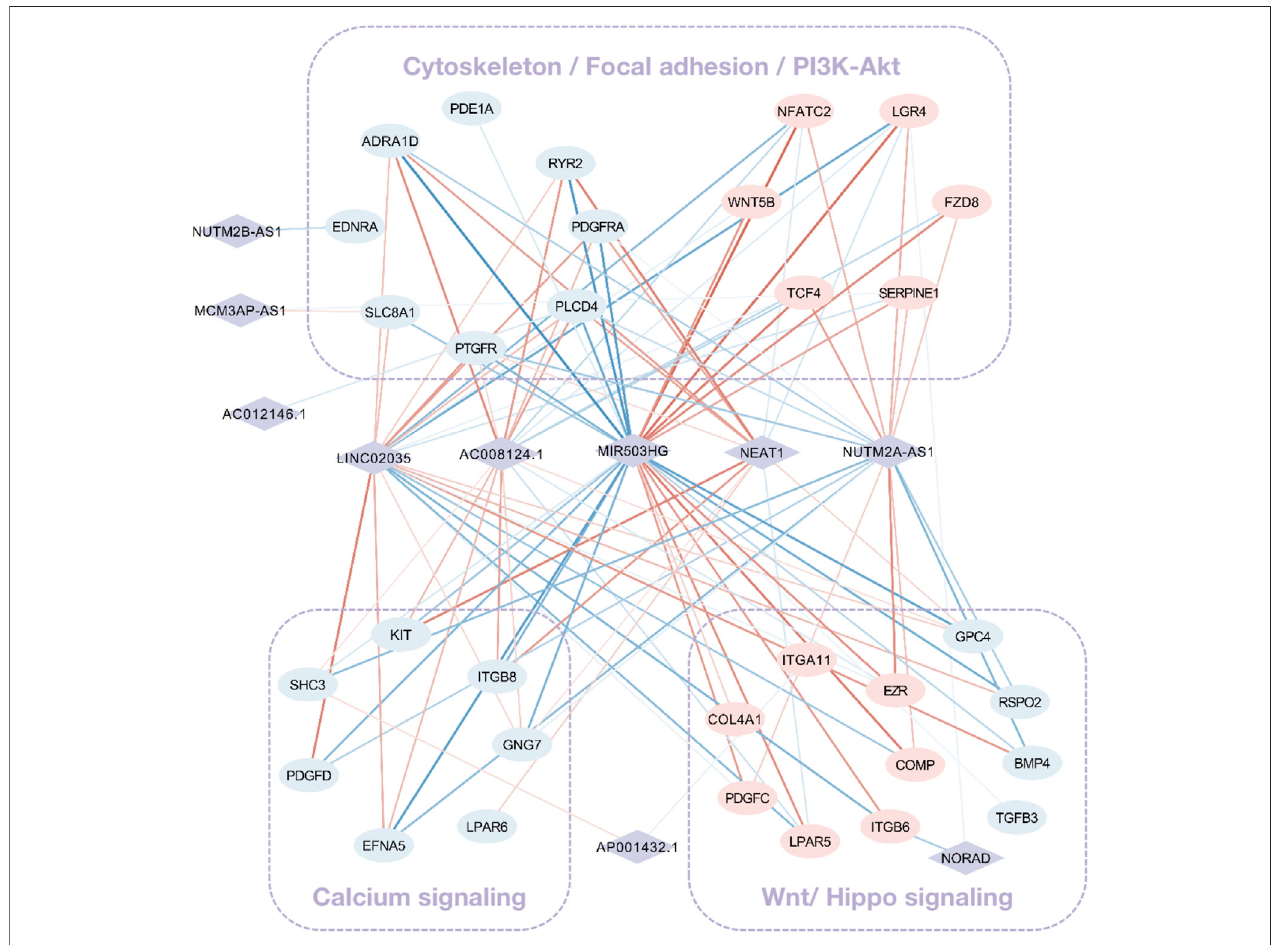
FIGURE 6 | The co-expression network among FS mRNA and FR lncRNA. Rhombuses and squares stand for lncRNAs and mRNAs, respectively. Upregulated RNAs are shown in pink, while downregulated ones are shown in blue. Red and blue lines represent positive and negative correlations, respectively. The widths of lines are mapped to correlation